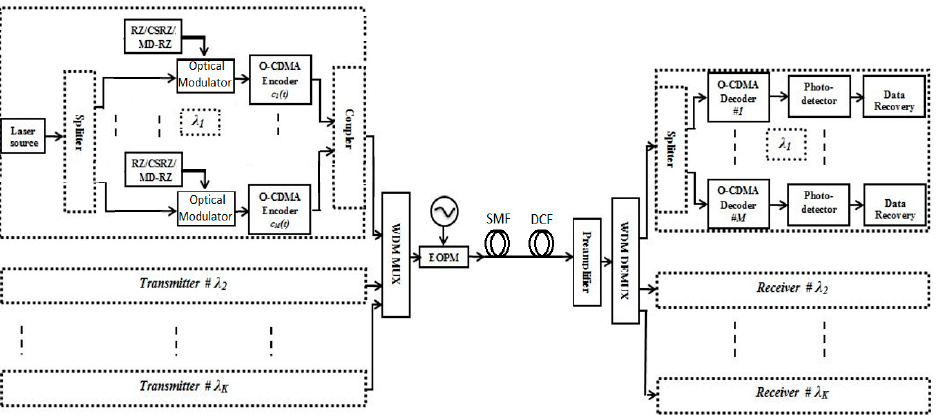
Figure 1. Hybrid Optical CDMA–DWDM system’s operational diagram. Single mode fiber (SMF) and dispersion compensating fiber